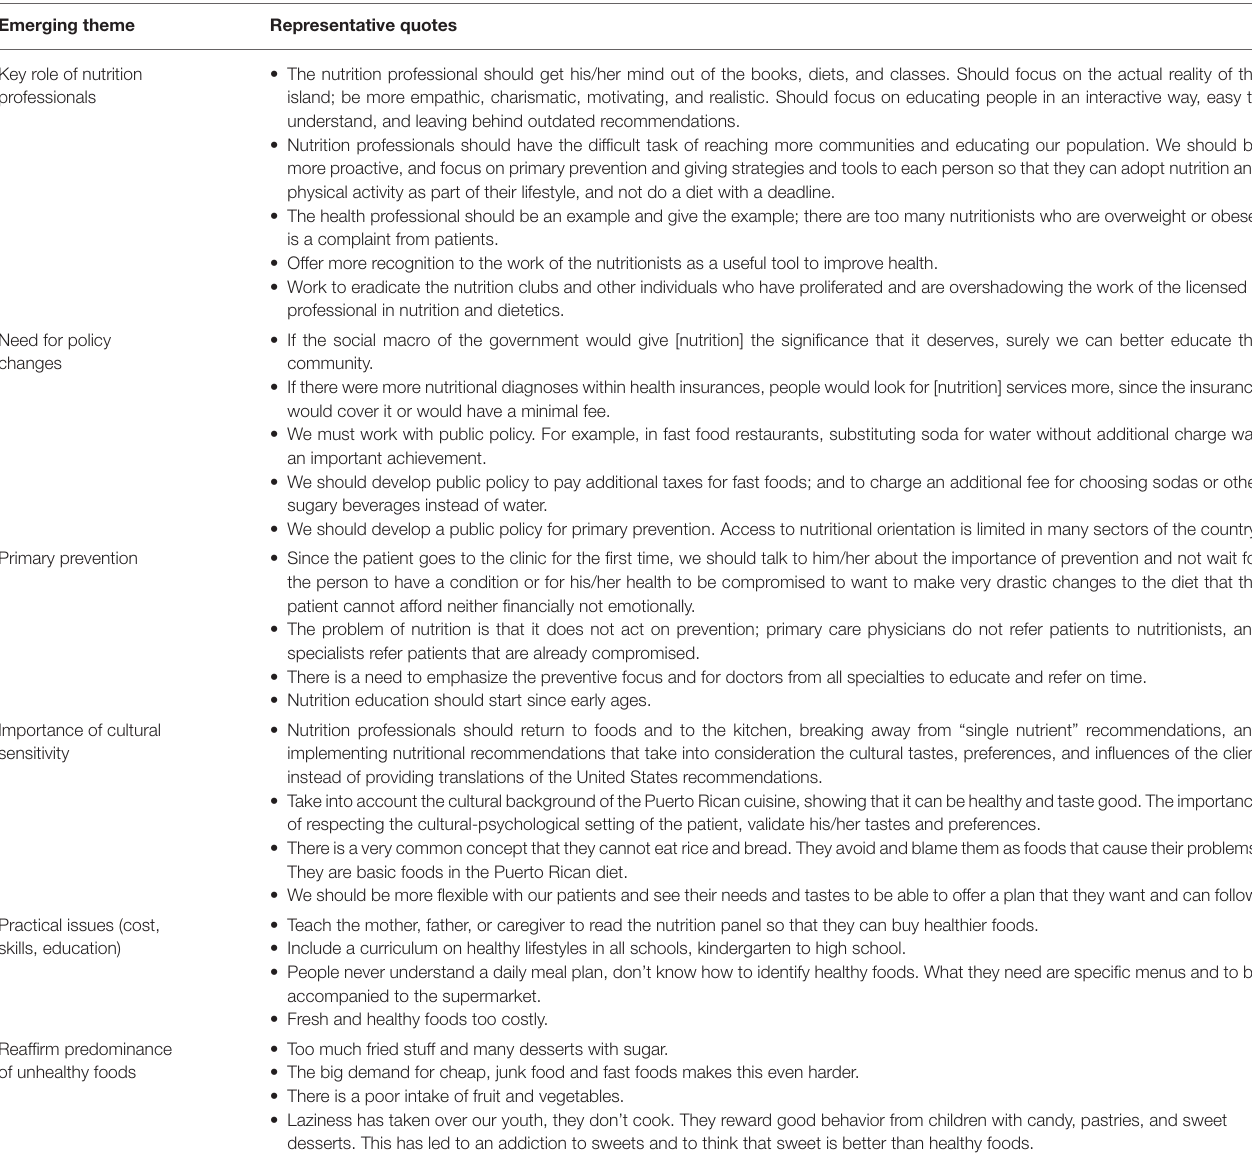
TABLE 1 | Emerging themes and representative quotes on healthy eating strategies as perceived by nutrition professionals, n = 98. Emerging theme Representative